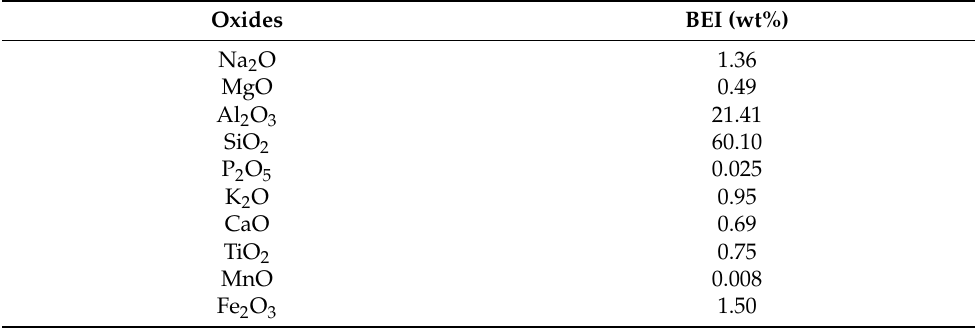
Table 1. Chemical composition of BEI